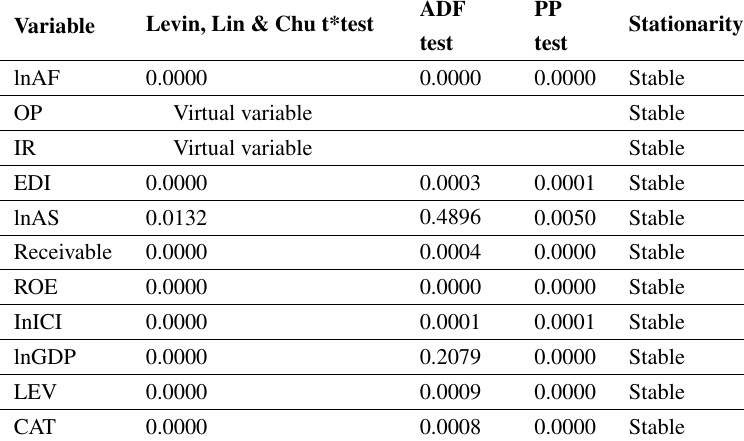
Table 3 Unit Root test for panel